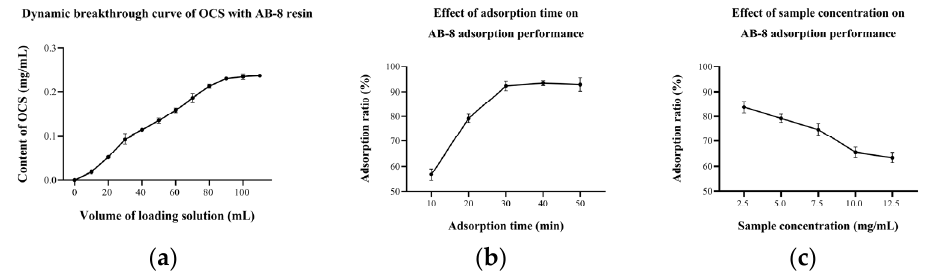
Figure 5. ( a ) Dynamic breakthrough curve of OCS with AB-8 resin; effect of ( b ) adsorption time and ( c ) sample concentration on AB-8 adsorption performance. ( c ) sample concentration on AB-8 adsorption